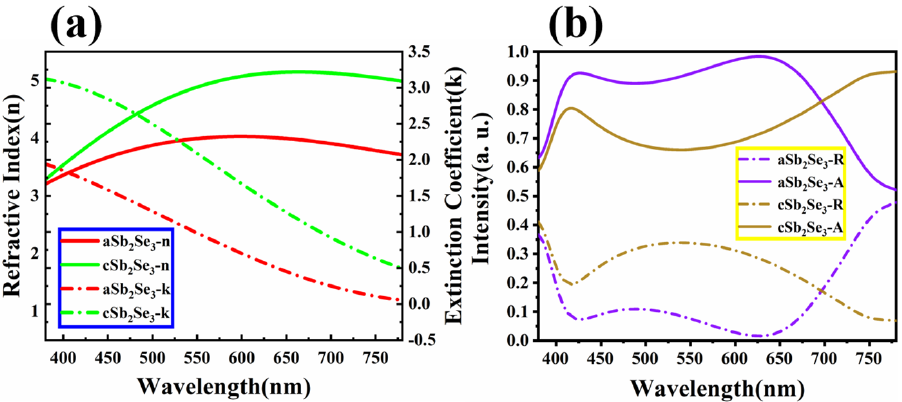
Figure 2. ( a ) Refractive index parameters of Sb 2 Se 3 under amorphous and crystalline states; ( b ) absorptivity and reflectivity of the structure under amorphous and crystalline states.